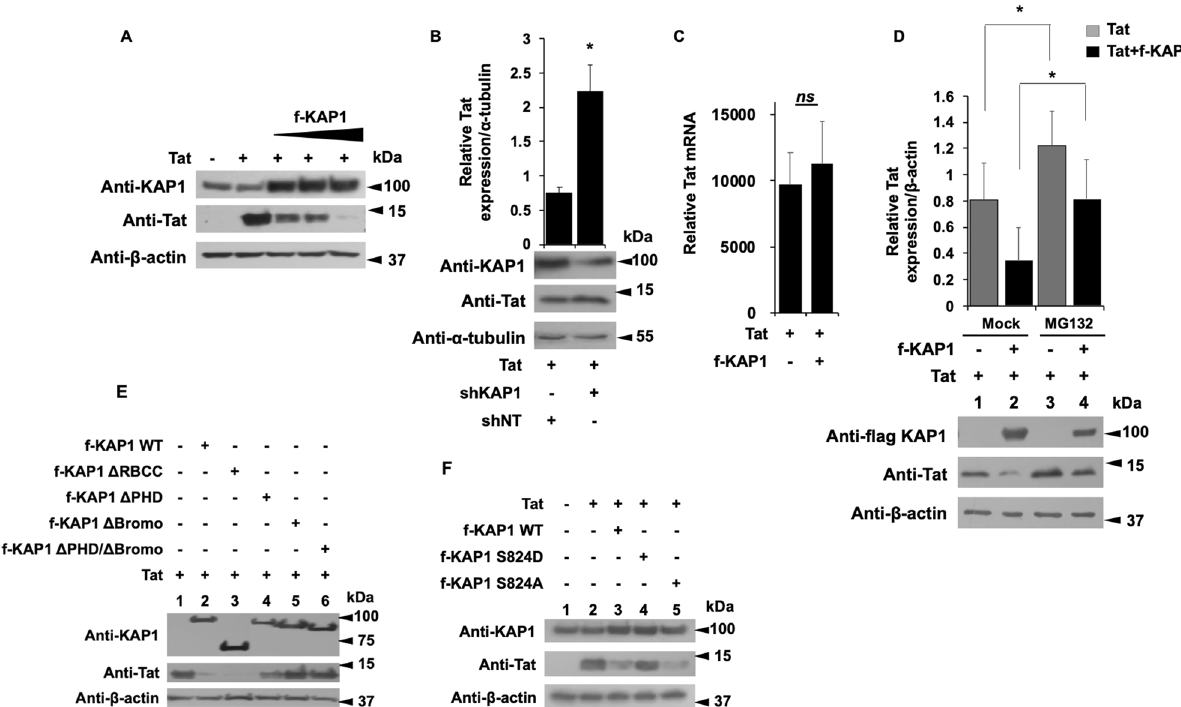
Figure 7. The Bromo domain of KAP1 promotes Tat degradation via the proteasome pathway ( A , B , E , F ) HEK cells were transfected with the indicated vectors. 48 h later, the nuclear proteins were analyzed by Western blot for the presence of the indicated proteins. ( B ) Tat expression level whose relative quantification to the α-tubulin was carried out using the image J software. ( C ) The RNA extracts from HEK cells transfected with the indicated plasmids were submitted to RT-qPCR experiments against Tat. The relative mRNA level of Tat was normalized to the GAPDH gene. ( D ) HEK cells were transfected with the indicated vectors. After 18 h of transfection, the cells were treated or not with 50 μM of MG132 for 6 h. 24 h post-transfection, the total protein extracts were analyzed by Western blot for the presence of KAP1 and Tat. Tat expression level was quantified